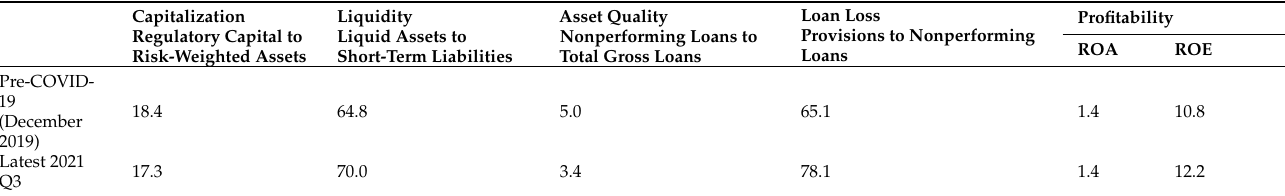
Table 1. Financial soundness indicators of Turkish banking sector